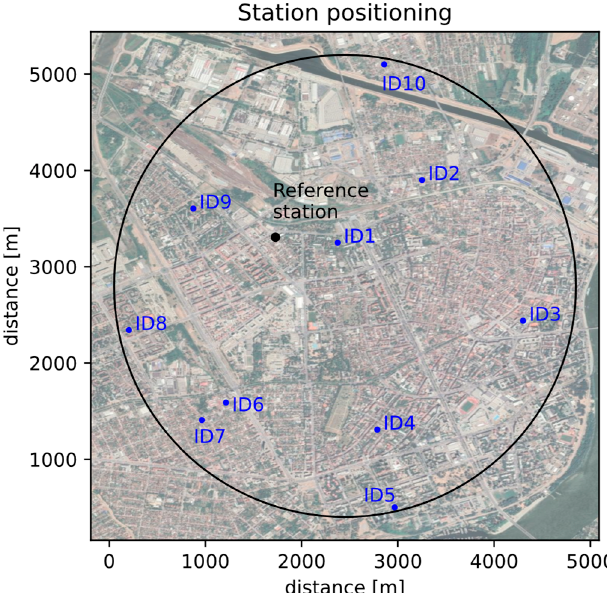
Figure 1. The spatial arrangement of measuring stations, Novi Sad, Serbia. ID1-ID10 represent the locations of the low cost devices used in the study.